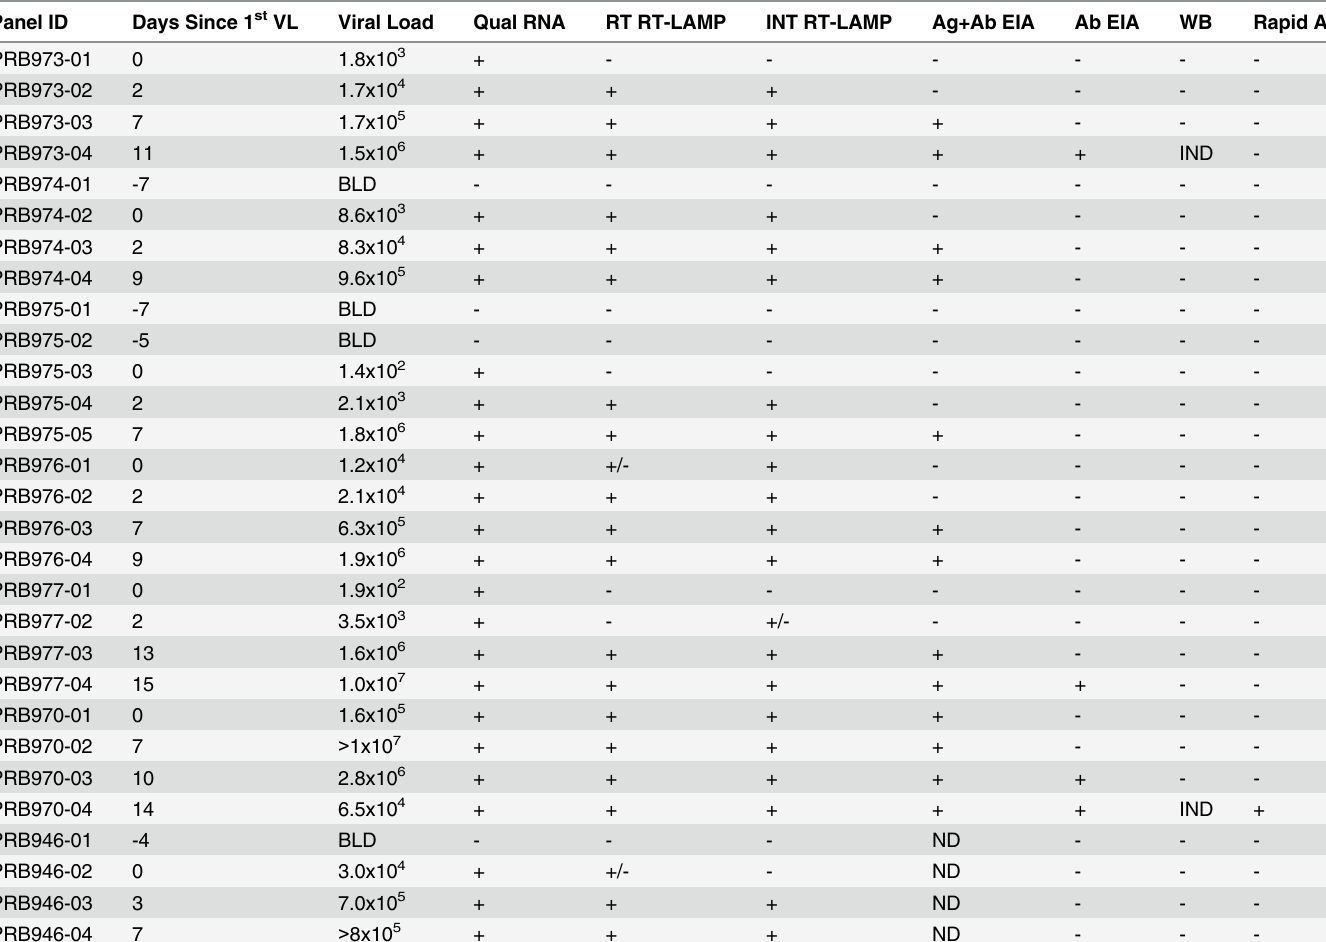
Table 2. Evaluation of RT-LAMP Assay with SeraCare Seroconversion